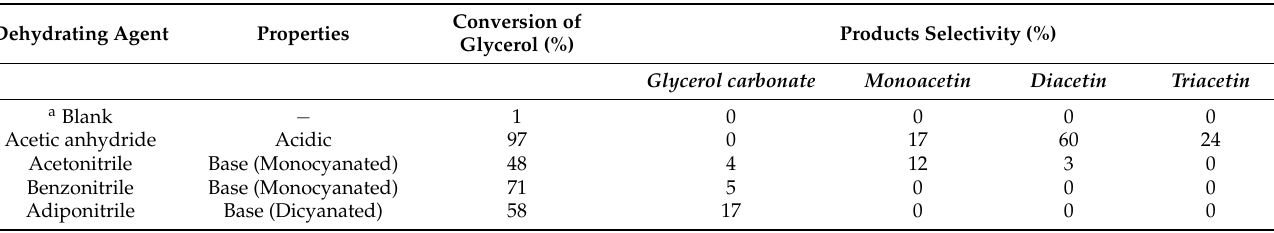
Table 2. The influence of dehydrating agents on glycerol conversion and selectivity to desired products. Reaction conditions: p = 45 bar, 6 wt.% C-La 2 O 3 , 22.5 mmol glycerol, 45 mmol dehydrating agent, 18 h and reaction temperature = 160 ◦